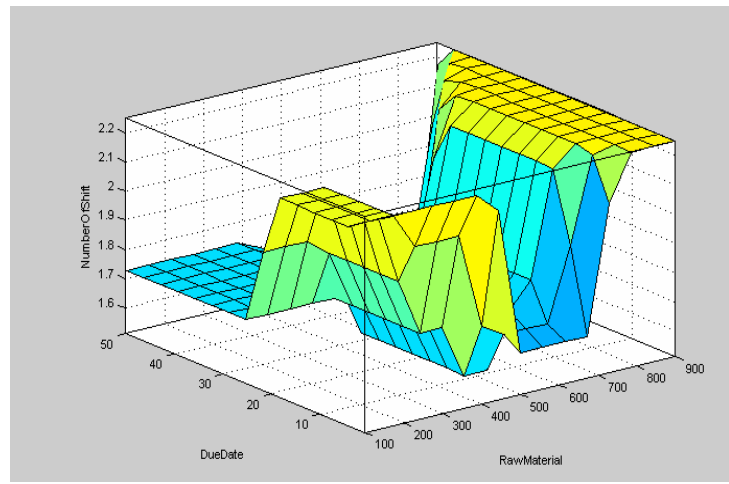
Figure 6. “Surface Analysis between Raw Material and Due Date with Number of Shift”. Source: Own contribution